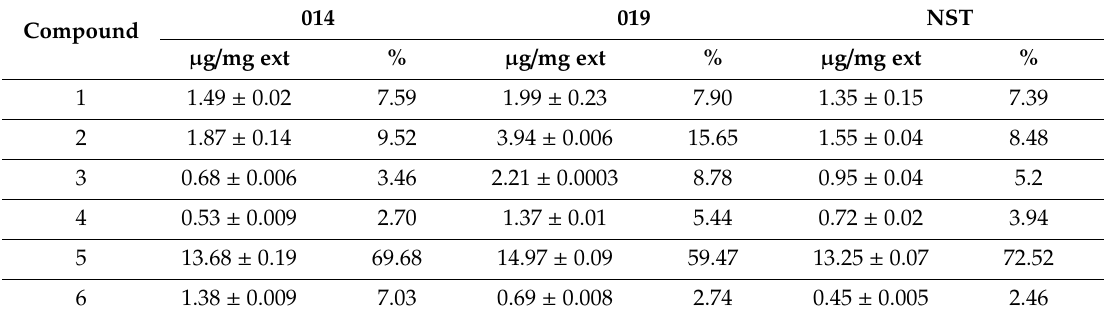
Table 2. Specialized metabolites identified in 019, 014, and the